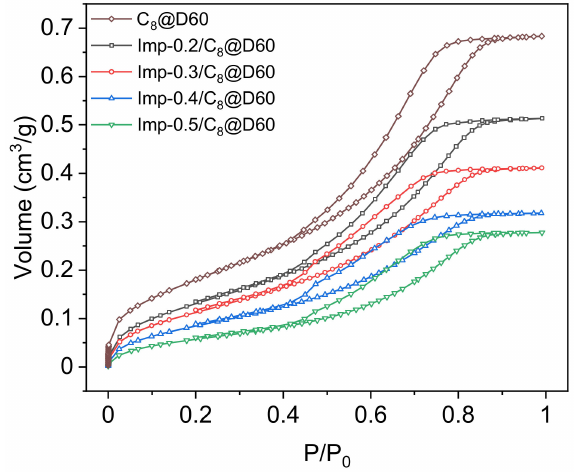
Figure 2. Nitrogen adsorption–desorption isotherms of the pre-functionalized support (C 8 @D60) and